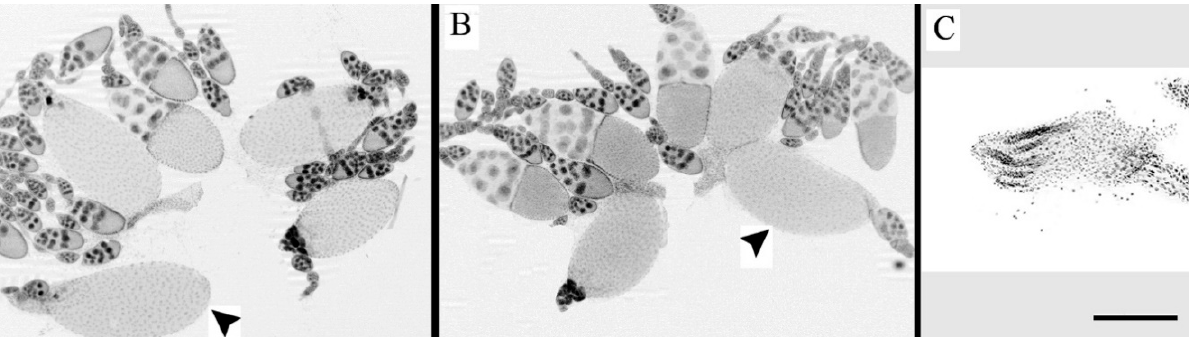
H C-S (non-dysgenic) females after incubation at 29 ◦ C. ♀ ♂ C-S H (dysgenic) ♀ ♂ C-S H (dysgenic) females at 29 ◦ C. Oogenesis does ♀ ♂